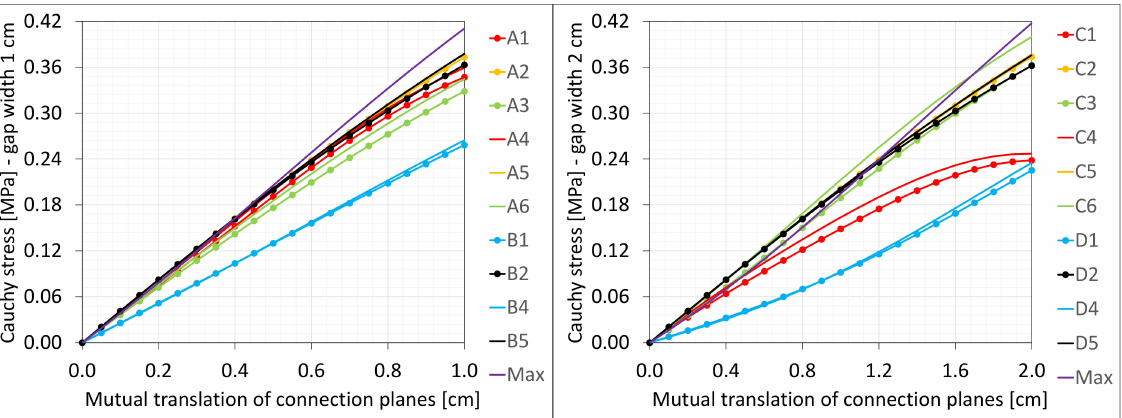
Figure 13. Equilibrium paths for stresses τ zy in selected nodes. The width of the gap is equal to 1.0 cm, left graphic, and 2.0 cm, right